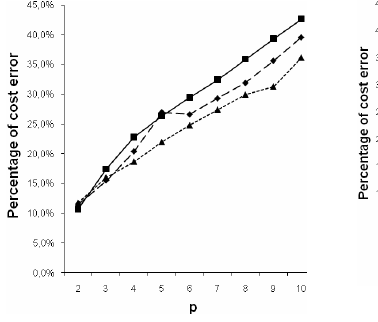
Figure 9. Cost error for 40 aggregated nodes.